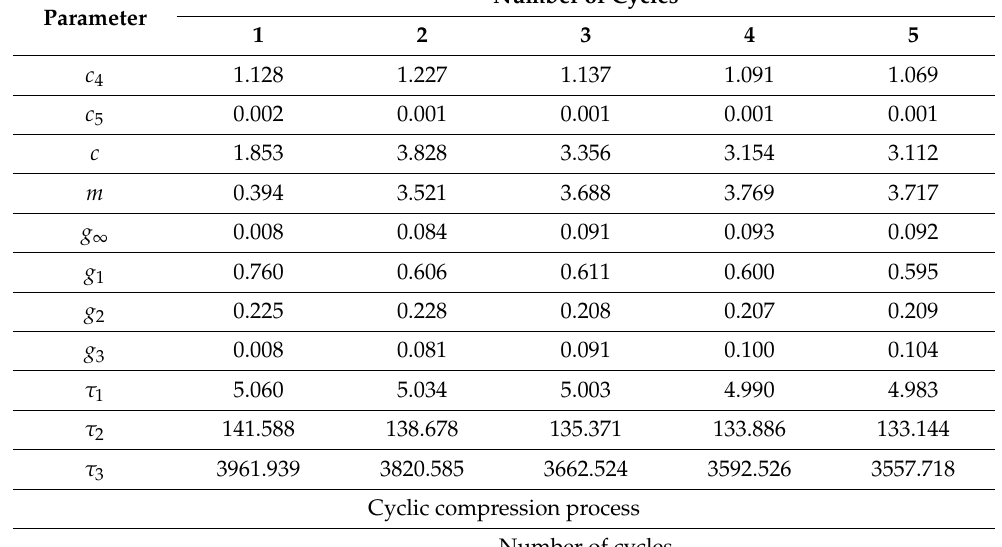
Cyclic Tension Process